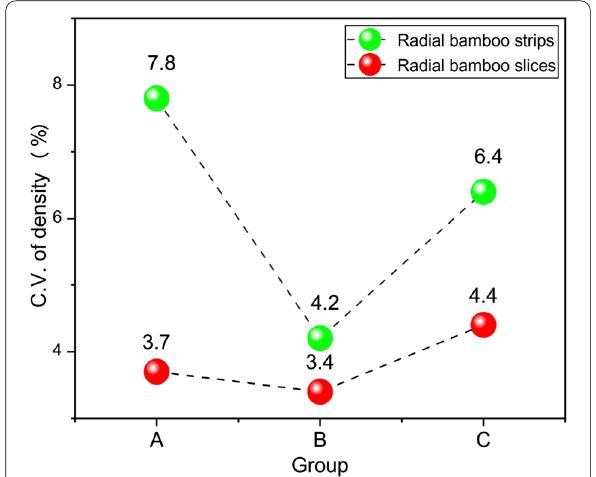
Fig. 6 C.V. of different layups. Note group A consists of poplar veneer and bamboo mat as surface layer. Group B consists of two bamboo mats as surface layer. Group C consists of two poplar veneers as surface